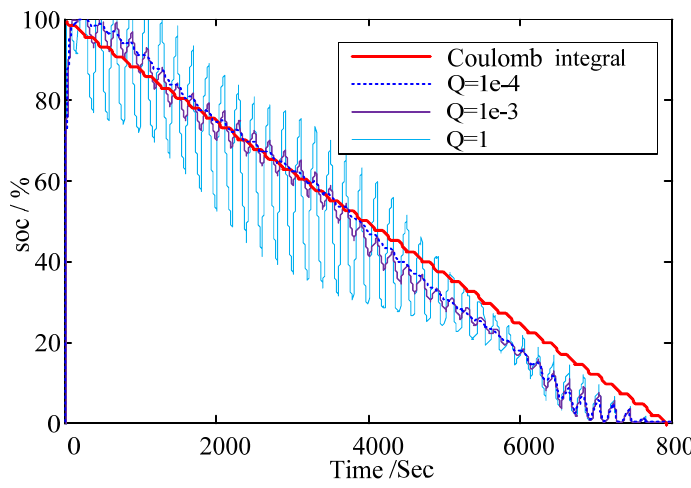
Figure 14. A large system noise worsens the filtering results.